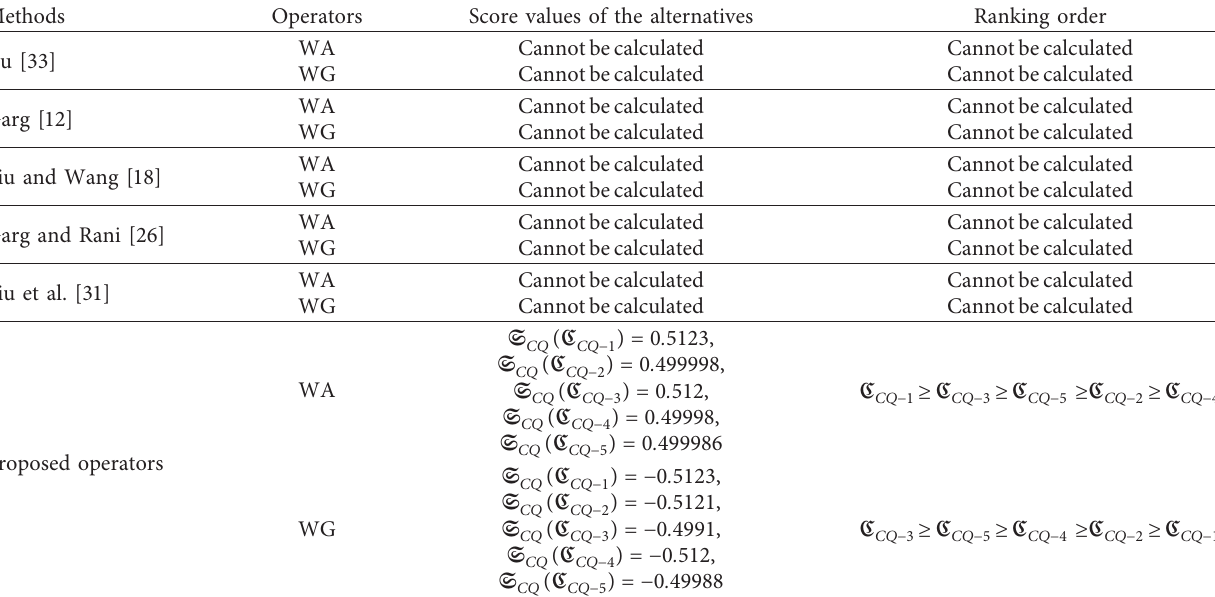
Figure 3: Geometrical representation of the alternatives discussed in Example 3. Table 7: Comparative analysis for the information corresponding to Example 1.